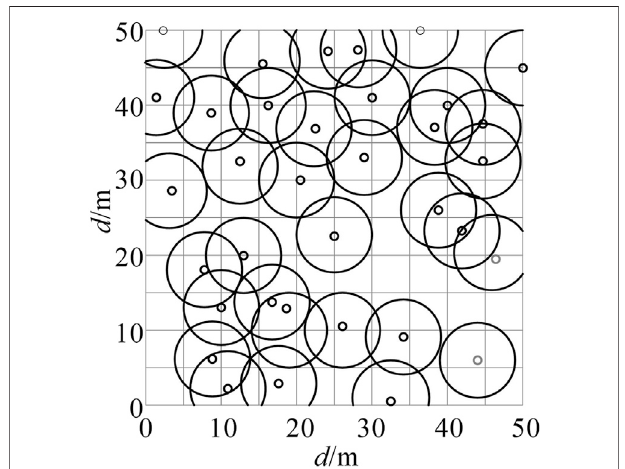
FIGURE 7 | Irregular failure.